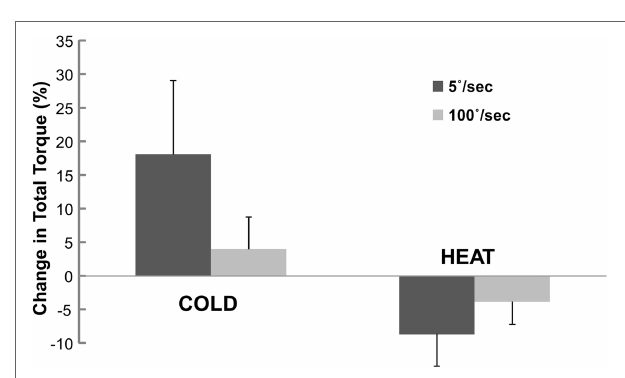
FigUre 4 | change in total torque at cOlD and heaT stimulation . Change in total torque refers to percent difference in total torque between COLD/HEAT and BASELINE that is normalized to total torque at BASELINE. Positive change means increase in total torque. Mean and SEs are shown.